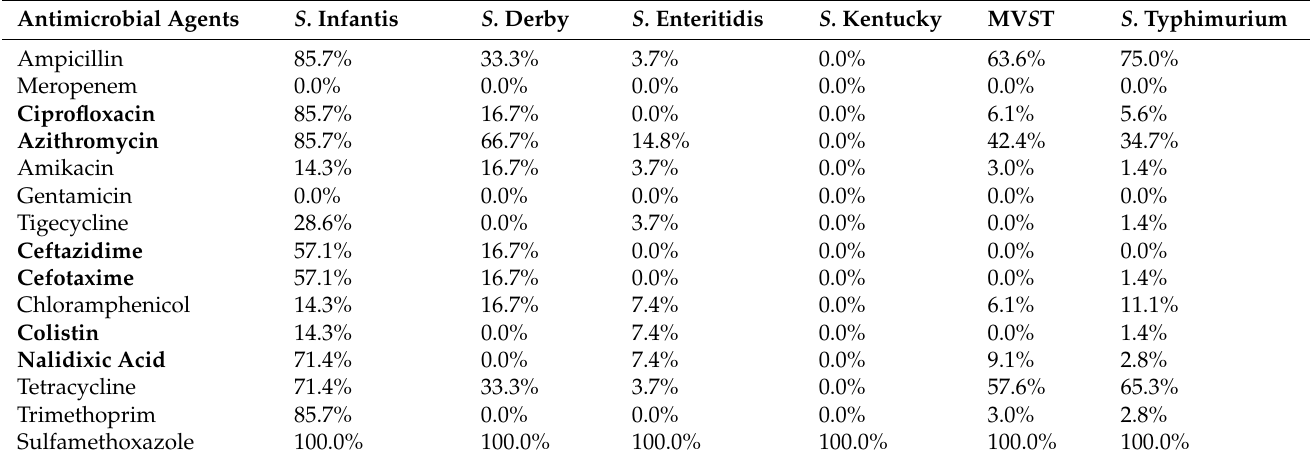
Table 3. Resistance to single antimicrobial agents in the serotypes of H strains. In bold are the highest priority critically important